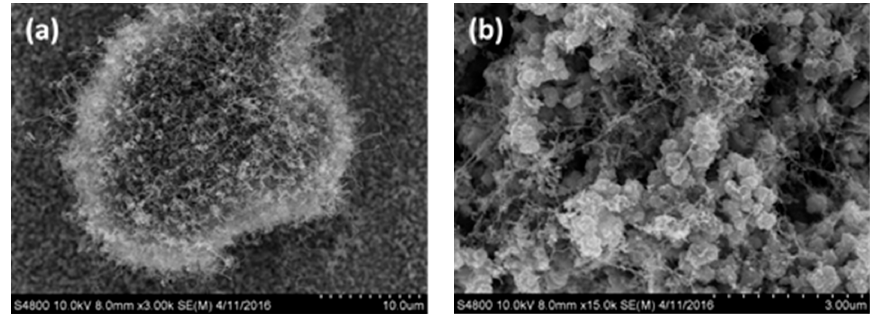
Figure 4. SEM images of carbon nanotubes prepared using argon gas at a flow rate of 100 sccm: ( a ) Magnified 3000 times; ( b ) Magnified 15,000 times.